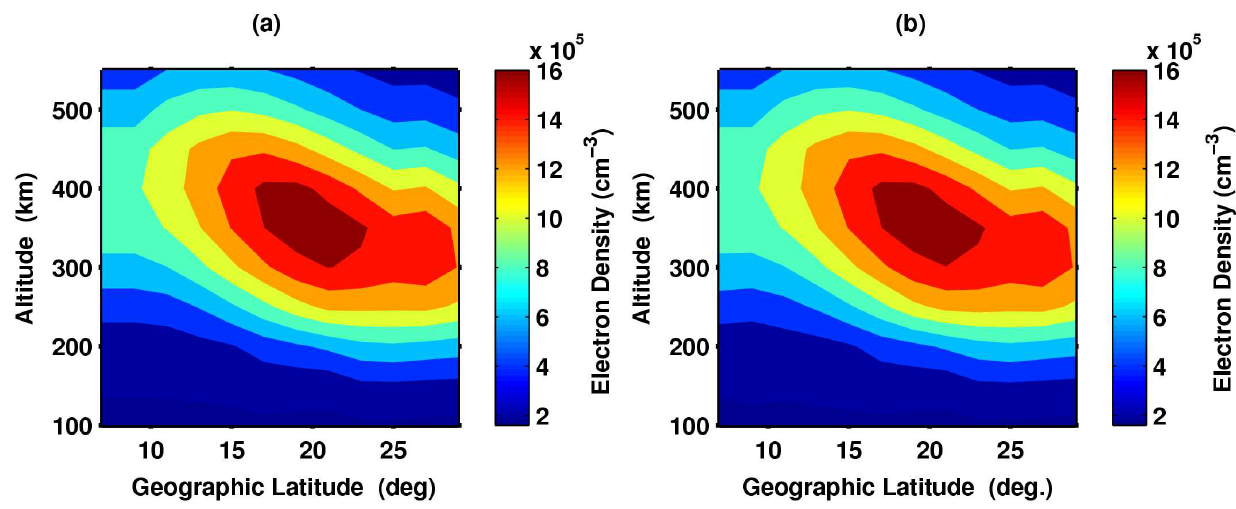
Fig. 2. ( a ) The model ionosphere used for generating TECs. ( b ) The tomographic reconstruction corresponding to Fig. 2a.